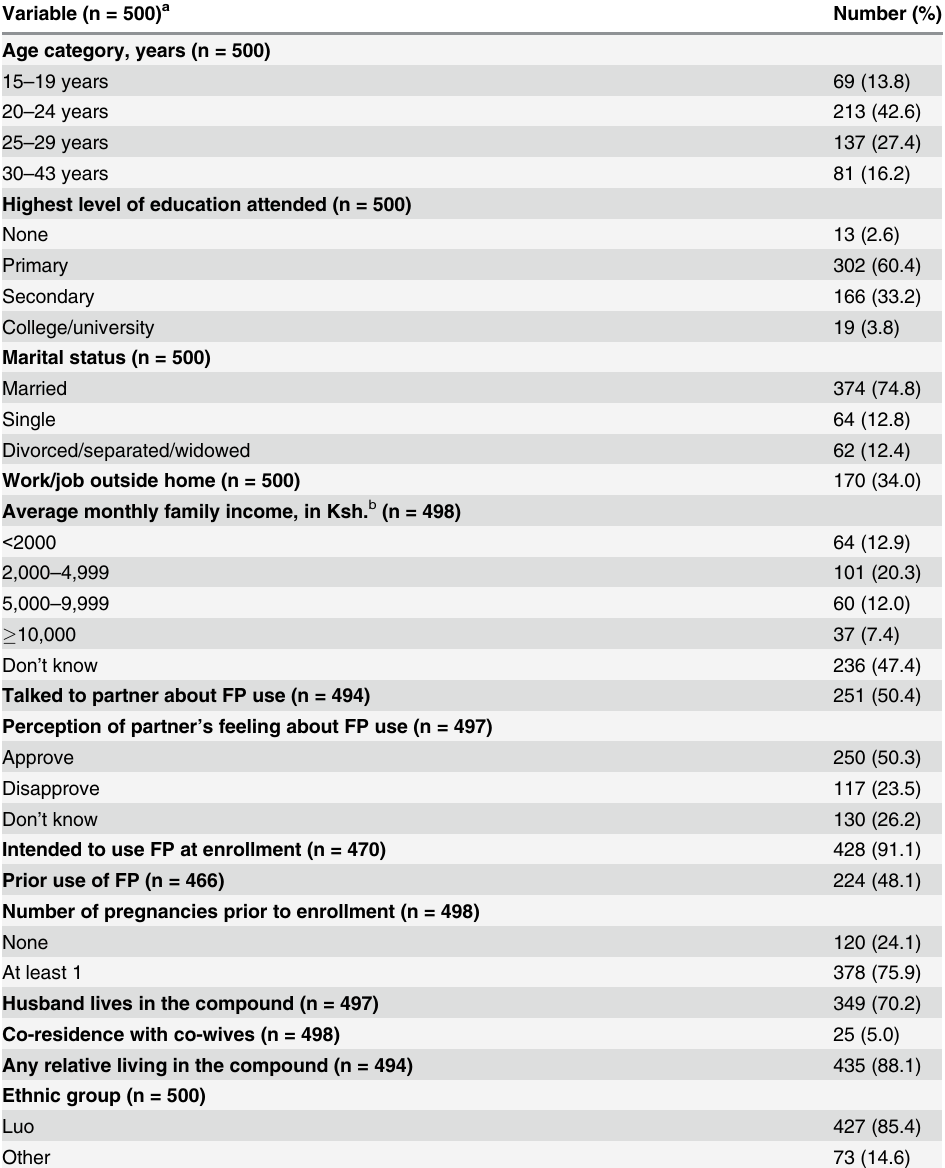
Table 1. Baseline maternal characteristics and behaviors of HIV-infected women in the Kisumu breastfeeding study, Kenya, 2003 –